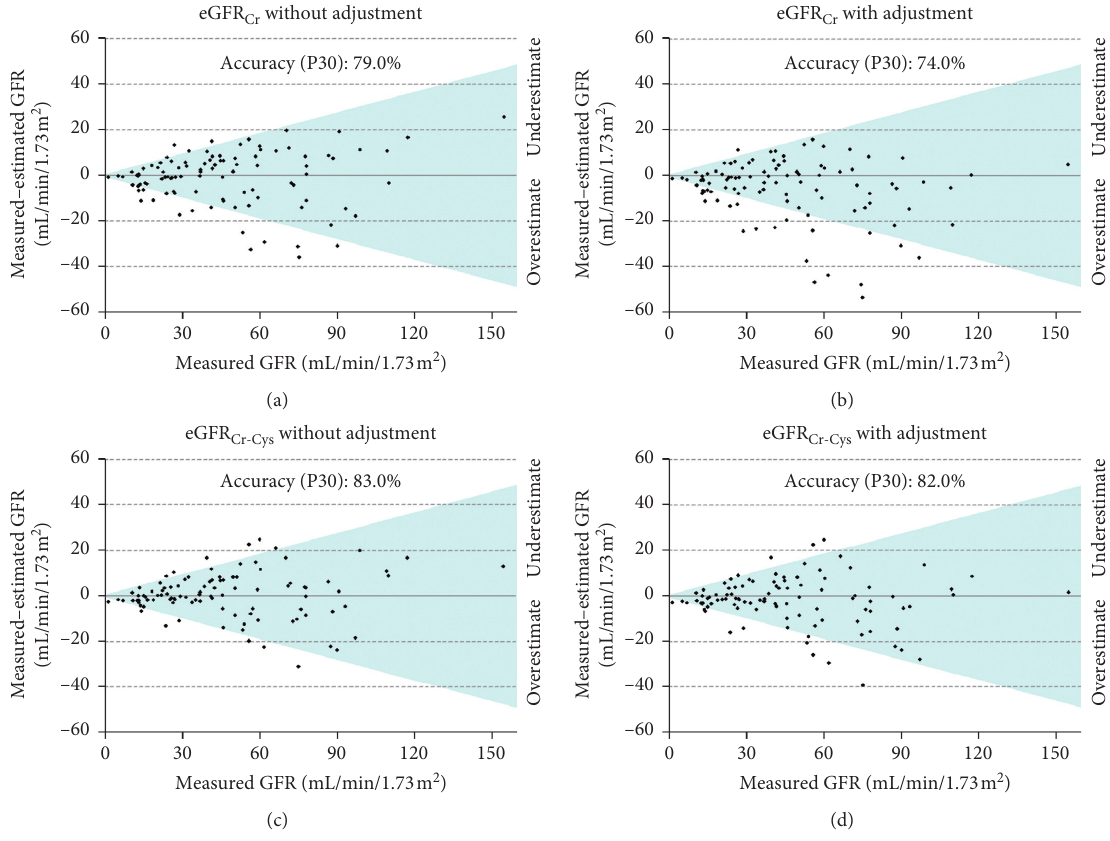
Figure 1: Accuracy of CKD-EPI equations for all participants ( n � 100), in which dots inside the colour area mean a difference between measured and estimated GFR lower than 30%